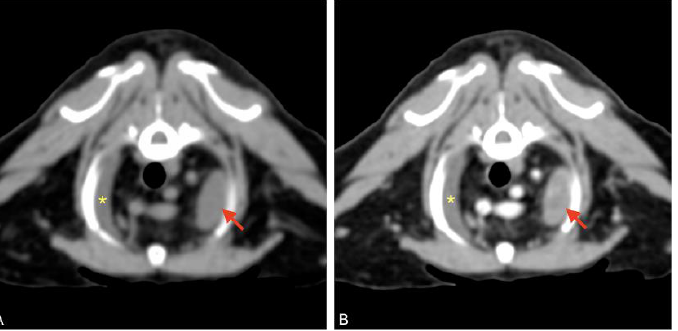
Figure 4. Pre ( A ) and post-contrast ( B ) images of the left-sided cranial mediastinal mass (red arrows), adjacent to the thoracic wall, ellipsoid-shaped, and heterogeneously enhanced. Mild pleural effusion is visible on the right (asterisk).